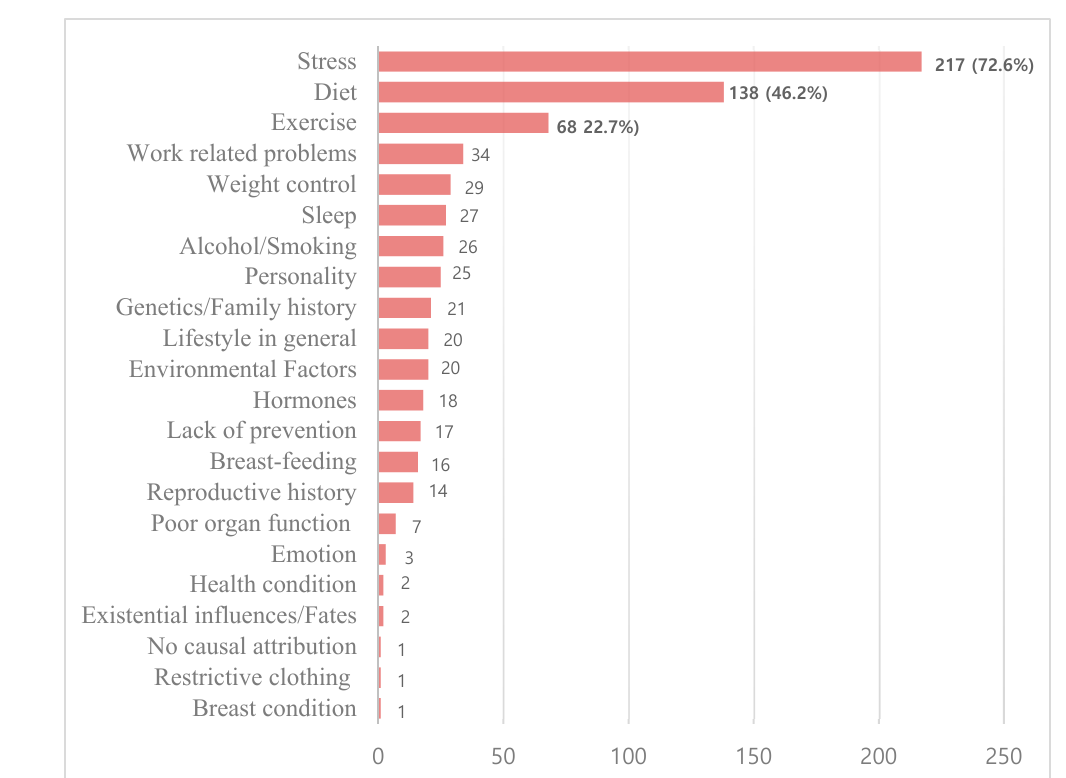
Figure 2. Frequency (number) of causal attribution categories reported by breast cancer patients.